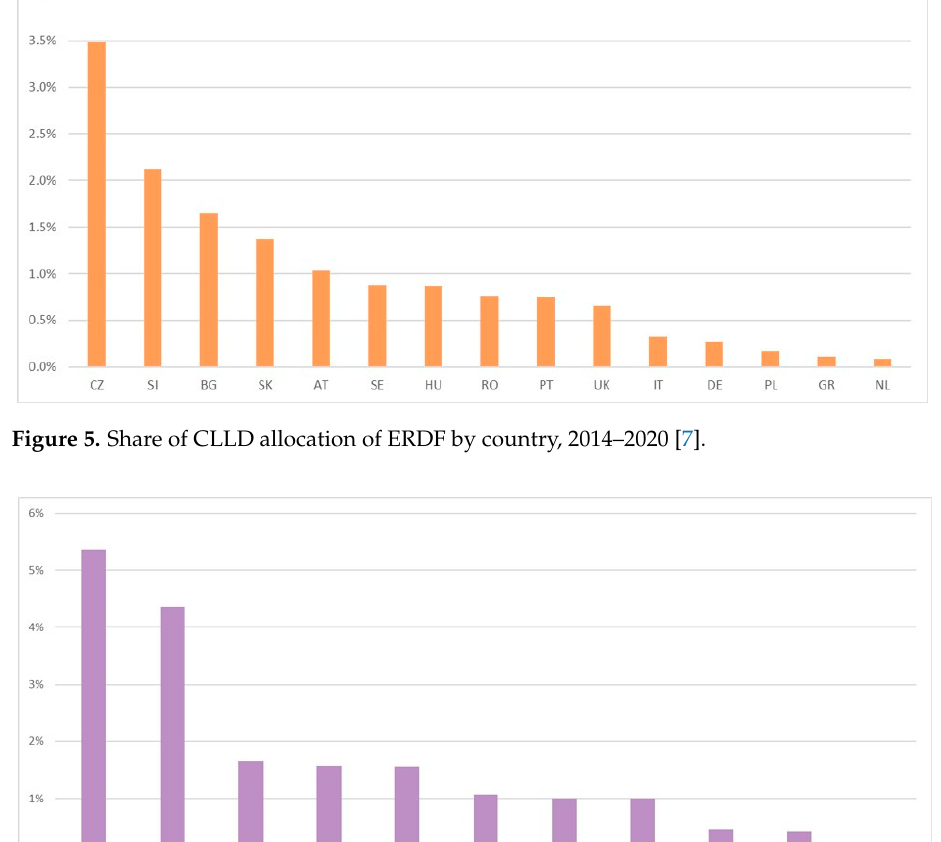
Figure 6. Share of CLLD allocation of ESF by country, 2014–2020 [7].